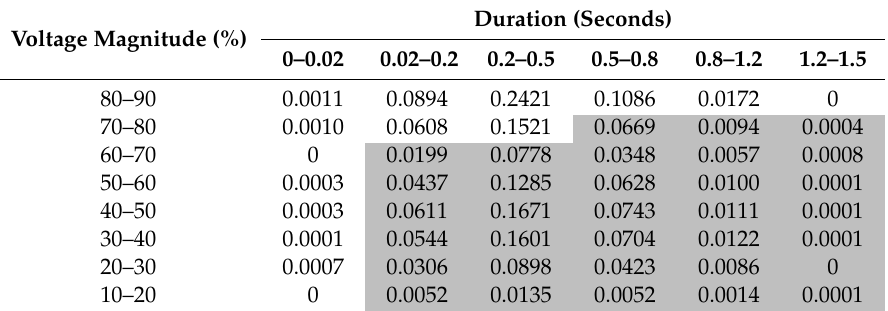
Table 3. SD for load point